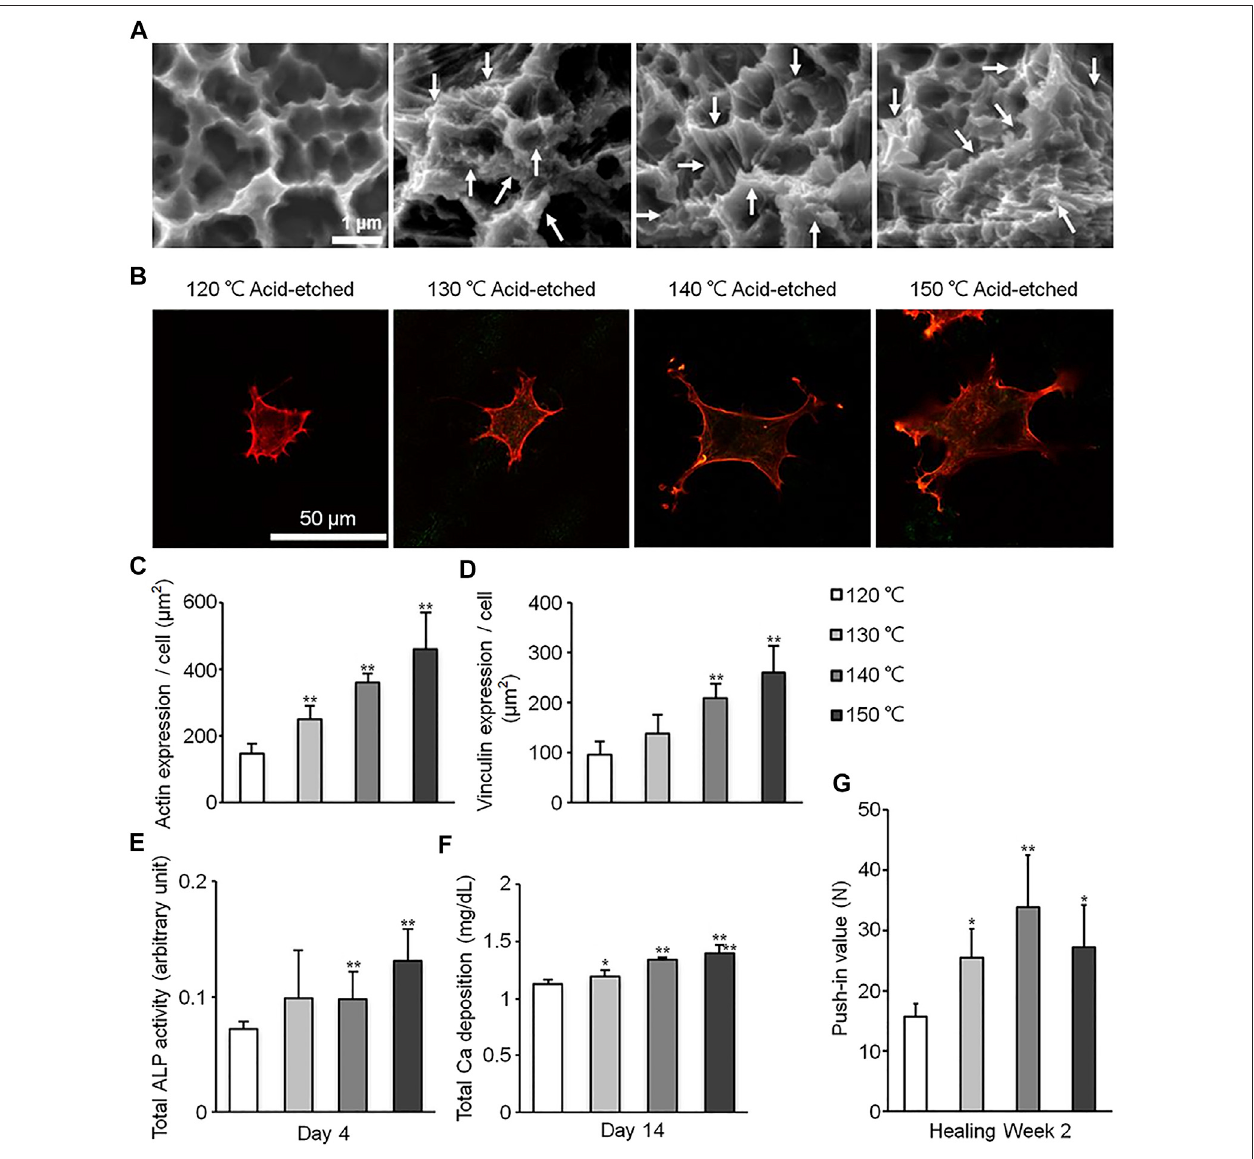
FIGURE1| Surfacesofdifferentscalesprocessedthroughacidetchingatdifferenttemperature. (A) Scanningelectronmicroscopy(SEM)photographsofsurfaces indifferentgroups. (B) Photographsofcellsstainedwithrhodaminephalloidin. (C – G) Quantitativeresultsofactinexpression (C) ,vinculinexpression (D) ,ALPactivity (E) , Ca deposition (F) and push-in value (G) . Reprinted with permission from (Hasegawa et al., 2020).